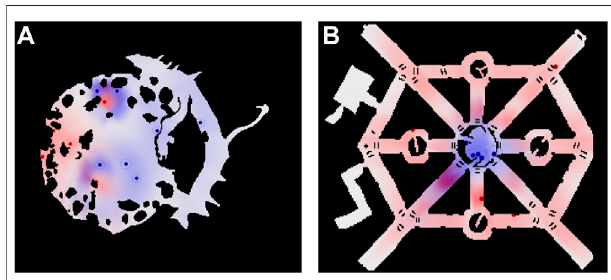
FIGURE 6 | Environments for which statistic are presented. (A) “ AR0414SR ” ; (B) “ AR0701SR. ” Each Panel also shows an example of the agent positions and distributions during one of the simulations. Blue hue indicates the evaders ’ prediction of pursuers ’ distributions, { q i } i ∈ C the red hue indicates the pursuers ’ prediction of the evaders ’ distributions, { p } j j ∈ C y